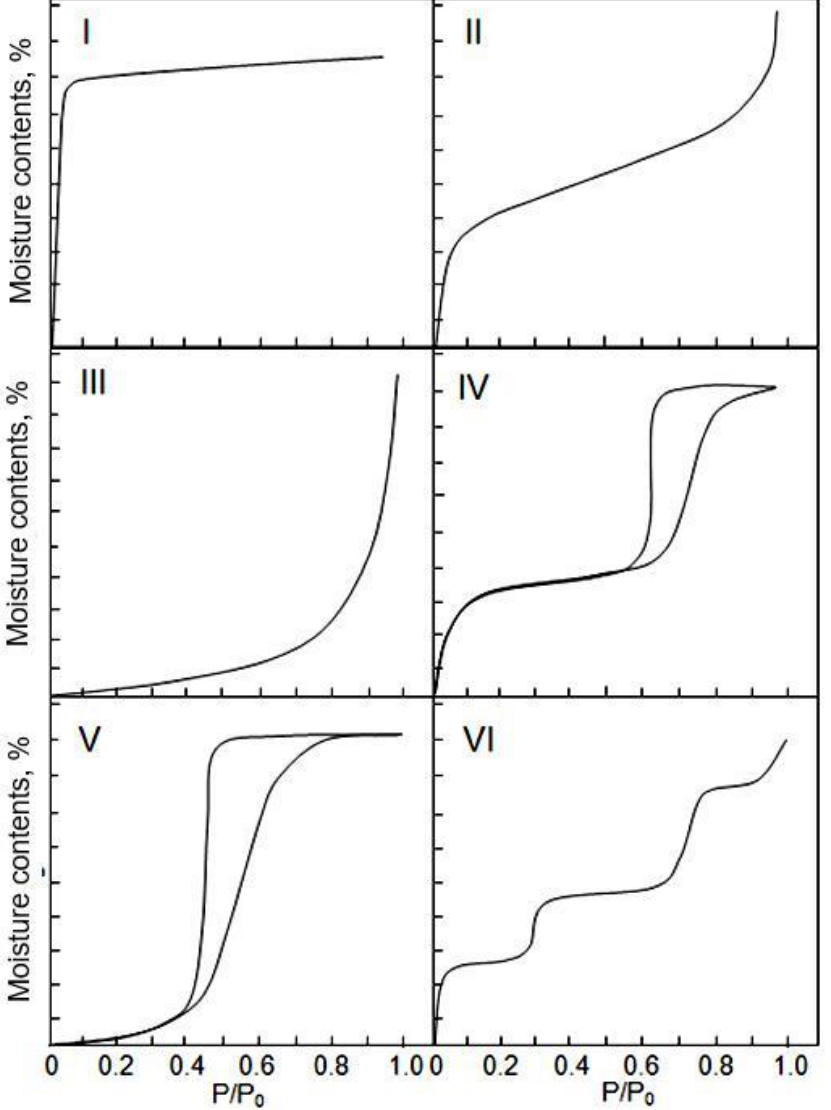
Figure 5. Basic shapes ( I – VI ) of sorption isotherms according to Brunauer S. Adapted from [219]. Published 1985 by IUPAC as open access.